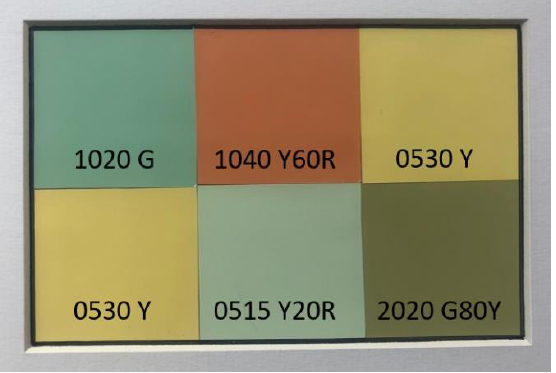
Figure 5. NCS color chart used for the color check for mango evaluation.